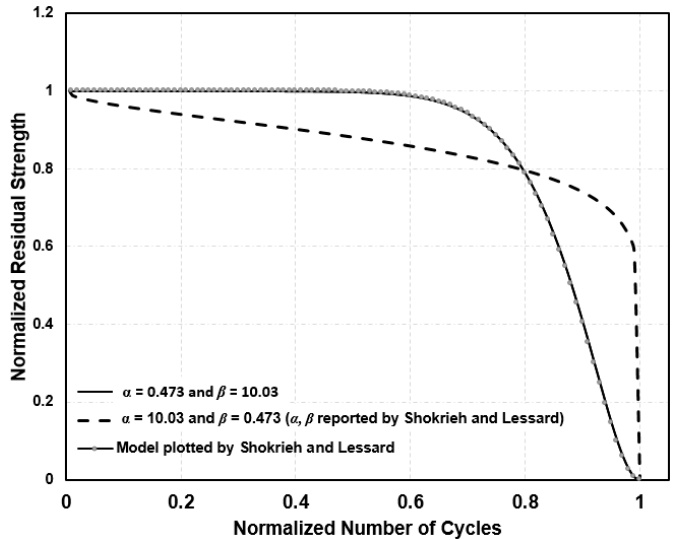
Figure 4. The normalized residual strength model for the 0° specimen tested by Shokrieh and Lessard showing the effect of the parameters α and β obtained from the test data.